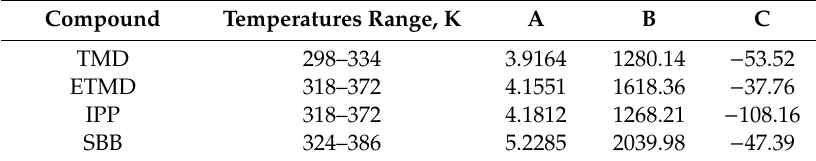
Table 9. The Antoine equation parameters for the 1,2-PD and 2,3-BD derived ketals and ethers. Compound